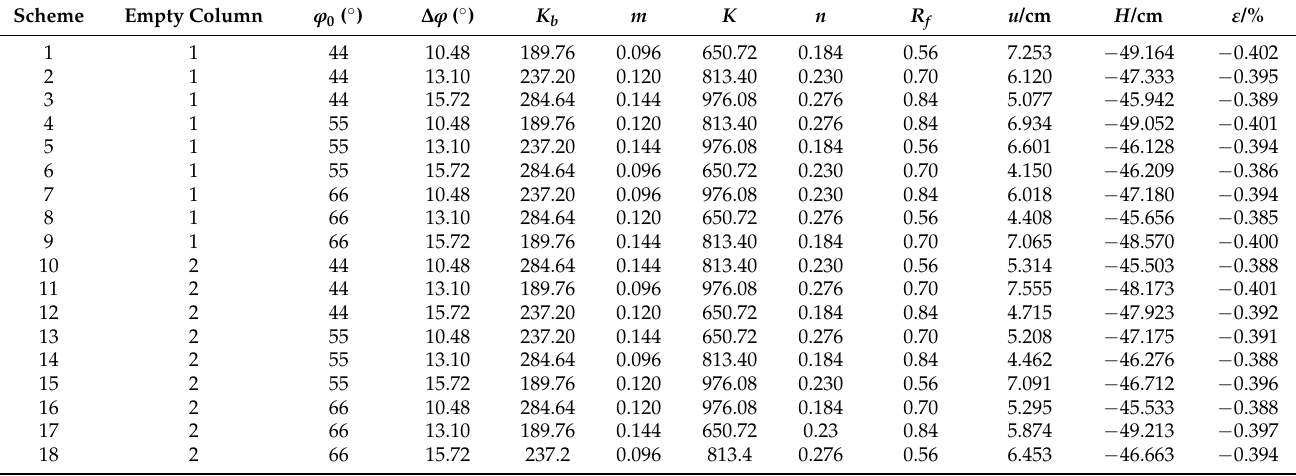
Table 6. Orthogonal test scheme and calculation results of secondary rockfill